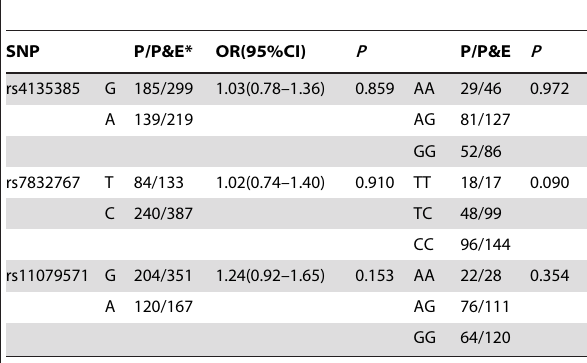
Table 4. Comparison of SNPs in PTB versus PTB combined extra-PTB patients.